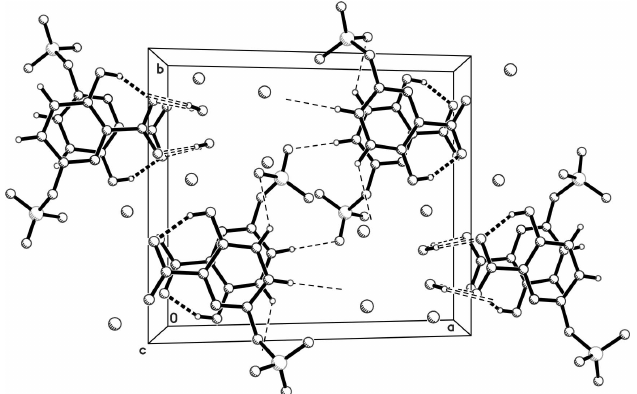
Figure 5 A view of the packing in I , viewed down the c axis. Intramolecular hydrogen bonds are shown as thick dashed lines, open dashed lines indicate strong intermolecular hydrogen bonds, and thin dashed lines denote weaker C—H (cid:2)(cid:2)(cid:2) O interactions. Dangling hydrogen bonds extend beyond the depth of the view.